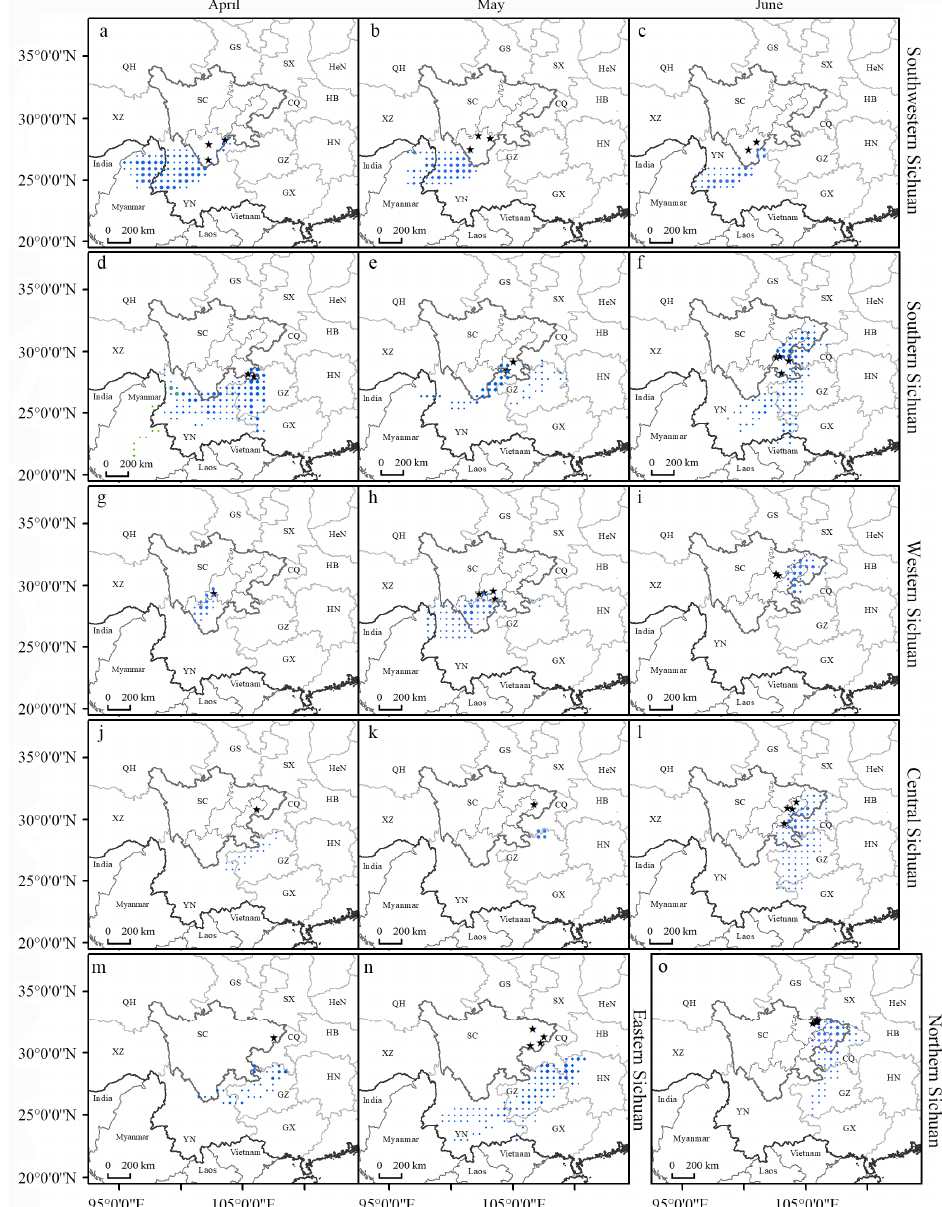
Figure 3. Distribution of endpoints for the FAW backward migration trajectories of the different regions of Sichuan Province from April to June. The black pentagrams are the starting points of the backward trajectories of each region. The region is labeled on the left of the panel, while the time periods of trajectories are labeled on the top. The distribution of dots indicates the distribution of source areas of FAW. The larger the dots are, the greater the distribution probability. The two-letter codes refer to the different provinces of China (SC: Sichuan Province, YN: Yunnan Province, GX: